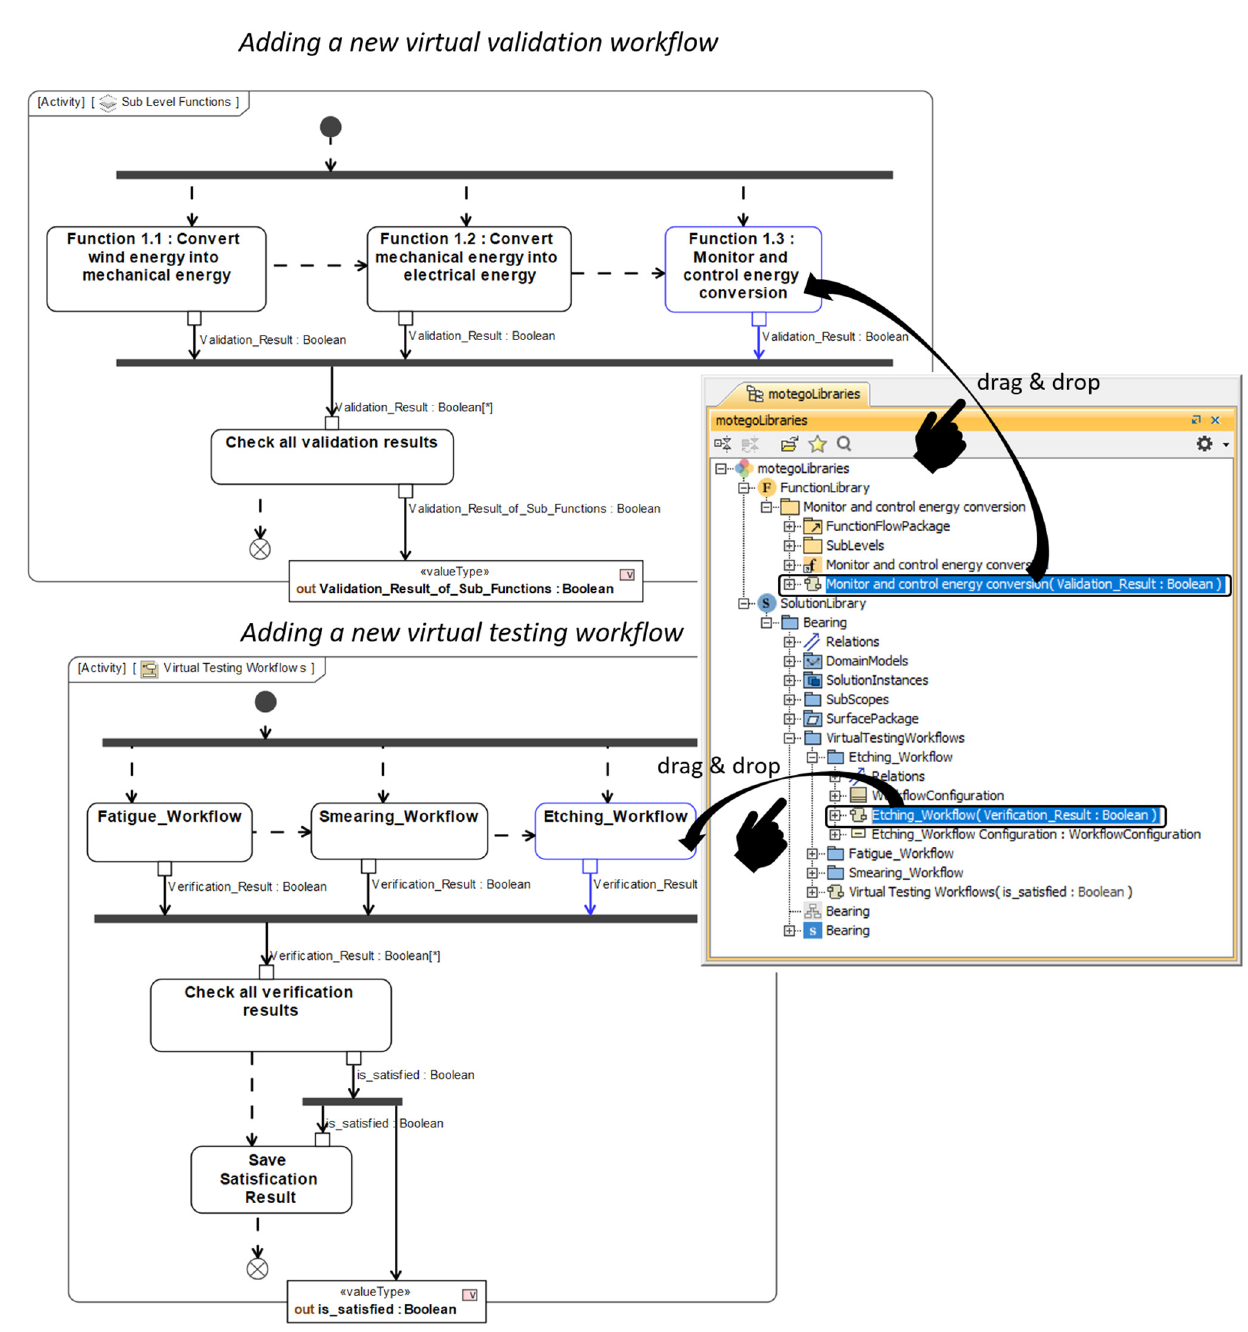
Figure 6. Adding virtual validation workflows & virtual testing workflows.